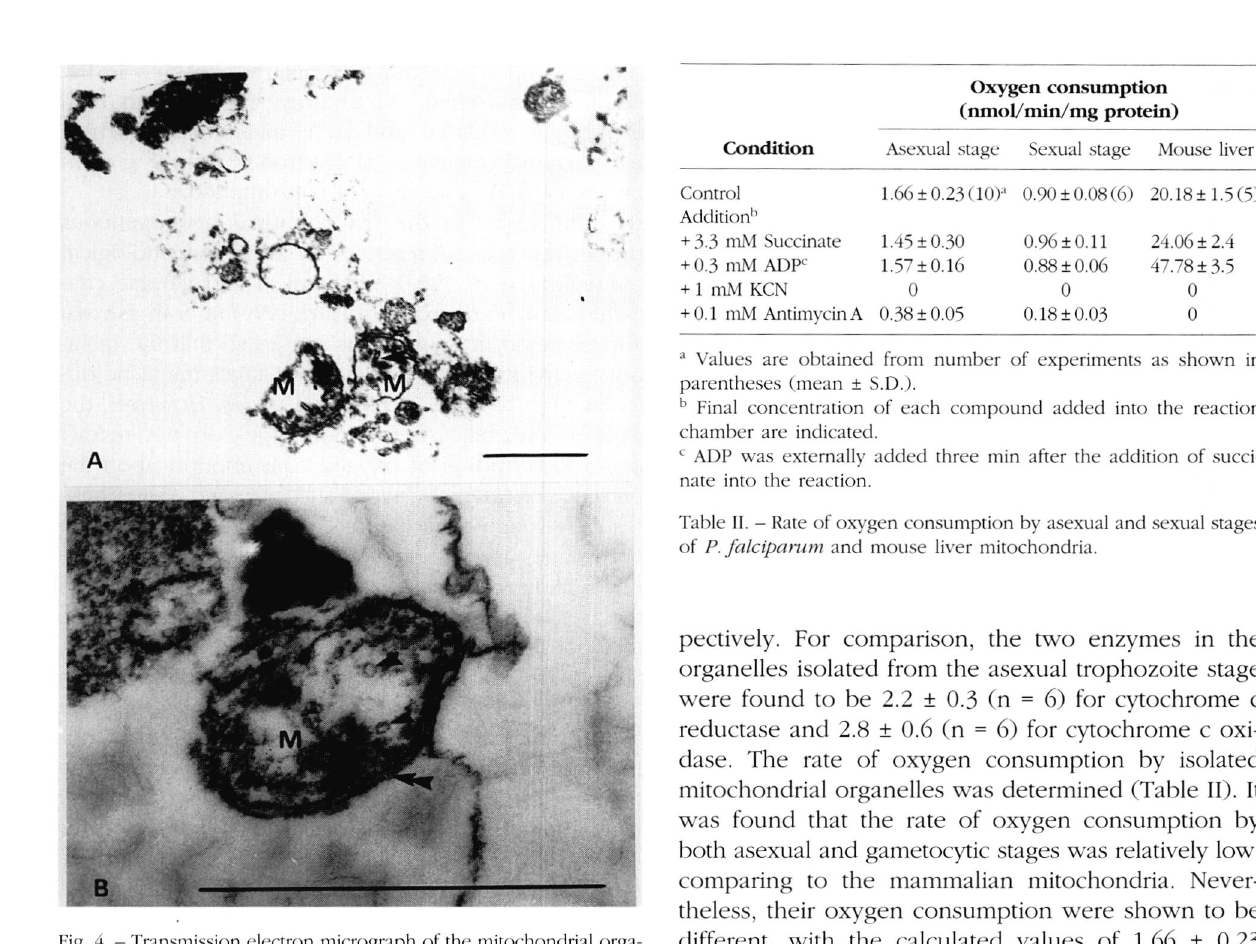
Fig. 4. - Transmission electron micrograph of the mitochondrial orga nelles isolated from sexual blood stage of P. falciparum. A The orga nelles contain many tubular cristate structures (arrowhead), as was found in the organelle of the intact parasite. B. A higher magnifi cation of an isolated organelle indicates the mitochondrion is still intact with clearly defined double membranes, marked by double arrowhead. The bar represents 1 µm. M, mitochondria.